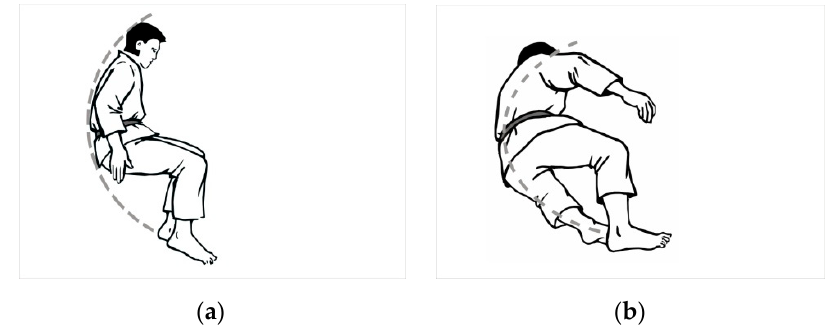
Figure 1. The back fall techniques ( a ) performing similar to a gymnastic backward roll ( b ) with side alignment of the body.